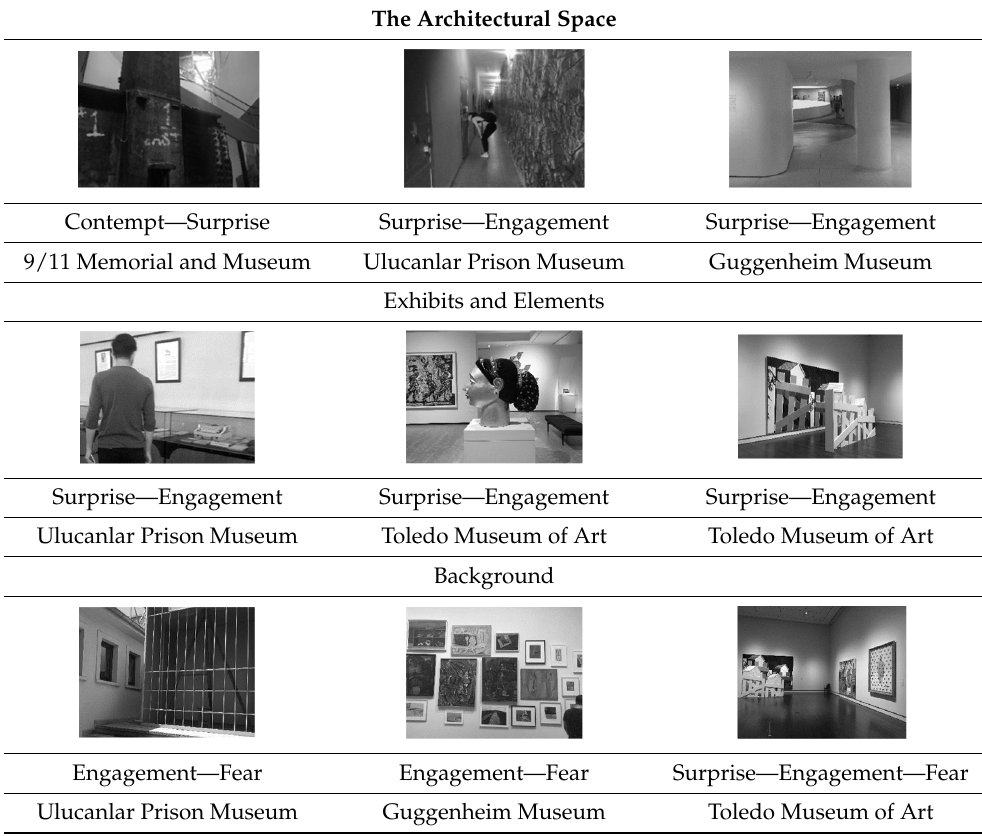
Table 2. Summary of findings with sample thumbnail photos representing different emotional reactions from each of the three themes.